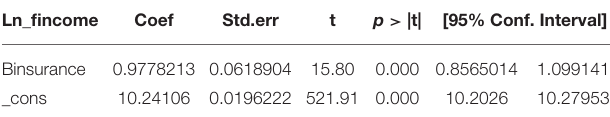
TABLE 8 | The mediate effect.